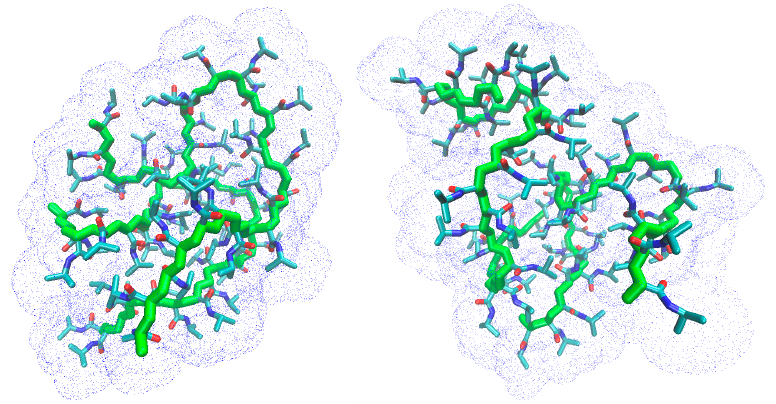
Figure 9. Snapshot at 202 ns of the trajectory of the atactic ( left ) and isotactic-rich ( right ) PNIPAM ensemble at 323 K. Water and hydrogen atoms are omitted. The blue dots display the solvent accessible surface. Table 2. Features of the interchain junctions at 323